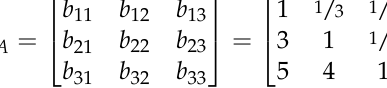
Table 1. Scale definition of AHP judgment matrix.